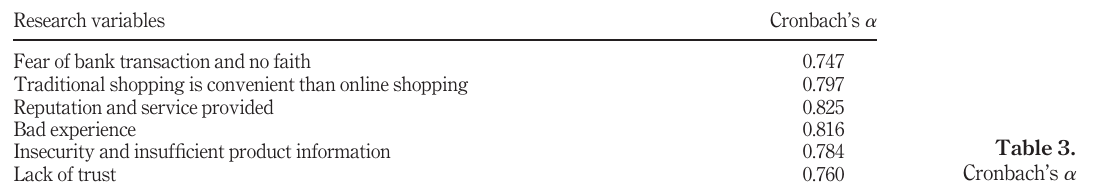
Table 3. Cronbach ’ s a